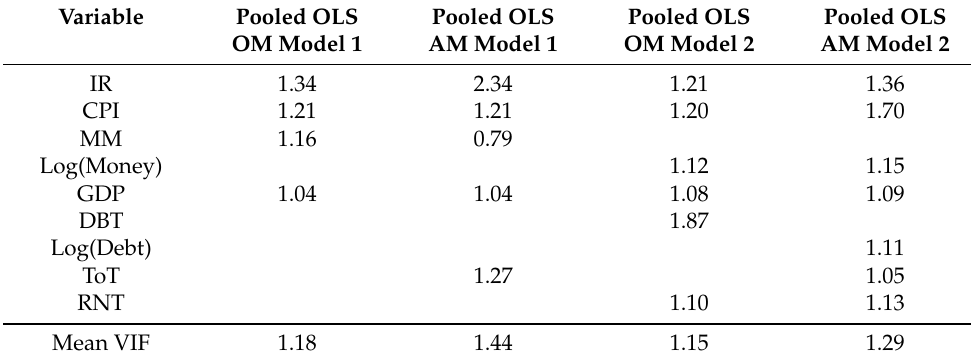
Table A2. Test of Multi-collinearity (VIF Values).